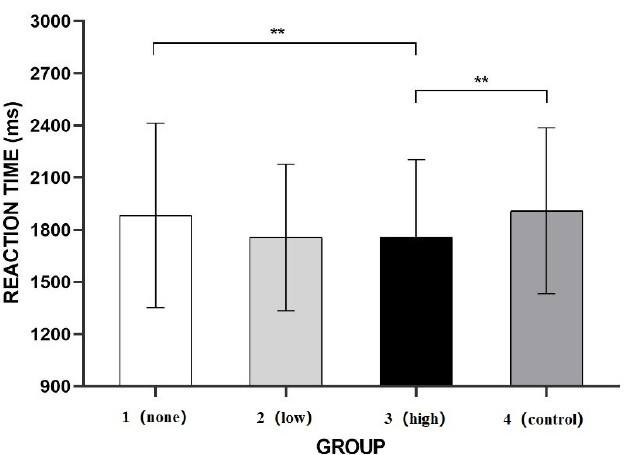
Figure 6. Reaction times to tourism scenes with different levels of greenery and colorful suppression images. ** p < 0.01.